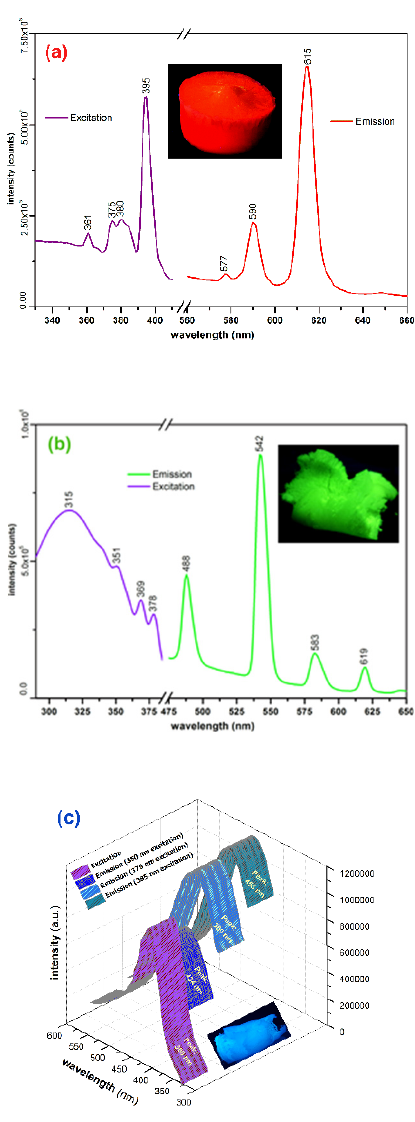
Figure 4. Excitation/emission spectra of prepared aerogels: ( a ) Eu(III) aerogel, ( b ) Tb(III) aerogel, ( c ) La(III) aerogel.